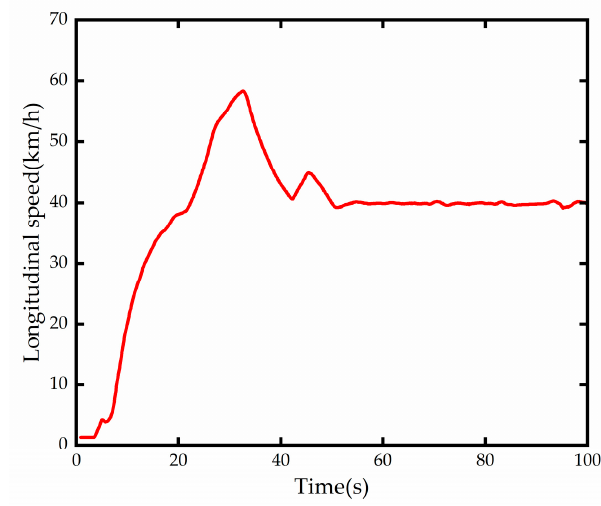
Figure 14. Road measured curvature change.